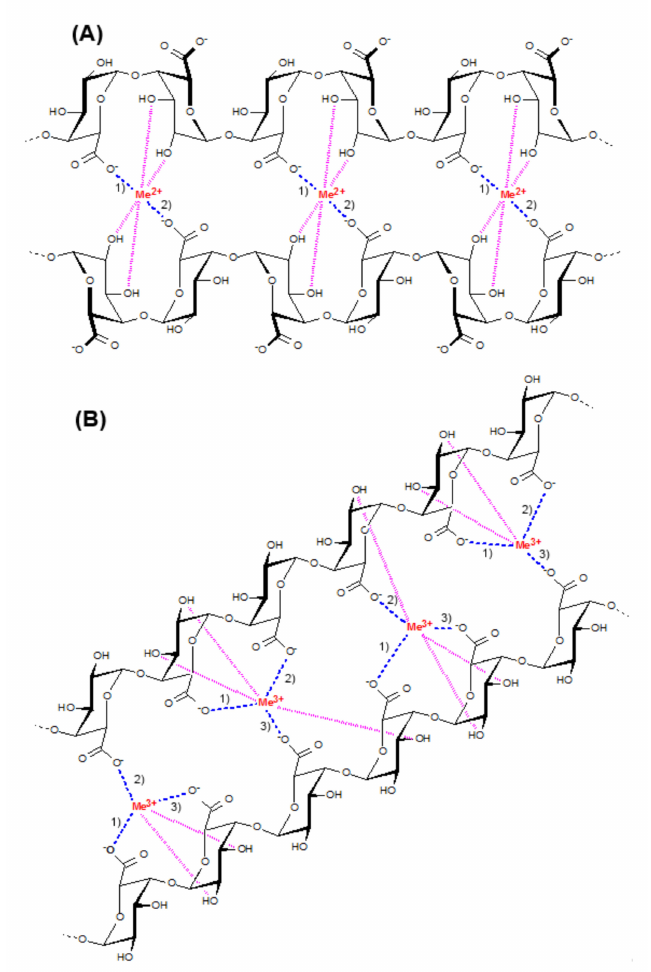
Figure 11. Mechanism presentation of the “egg-box” model of pectin gelation induced by divalent (Zn 2+ and Ca 2+ ) ( A ) and trivalent (Fe 3+ and Al 3+ ) ( B ) cations. Numbers 1, 2, and 3 indicate ionic bonding; pink dotted lines indicate hydrogen